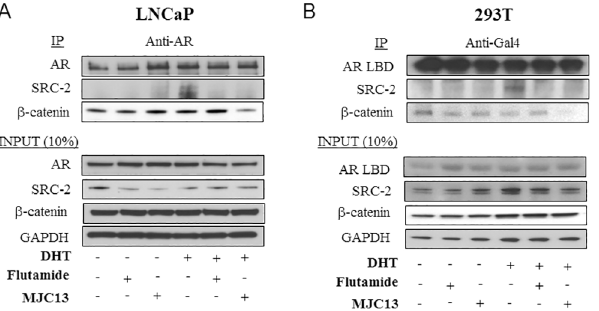
Fig 8. MJC13 blocks AR interaction with coactivators. (A) Co-immunoprecipitations from extracts of LNCaP cells treated +/- DHT (1nM), +/- flutamide (1 μ M), or +/- MJC13 (30 μ M) for 12 h. AR antibody was